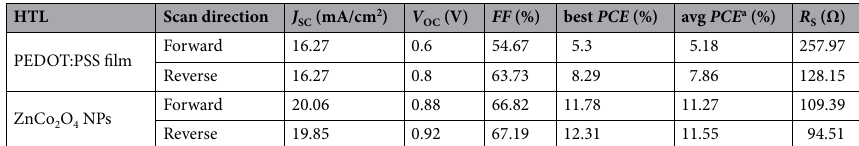
HTL Scan direction J SC (mA/cm 2 ) V OC (V) FF (%) best PCE (%) avg PCE a (%) R S